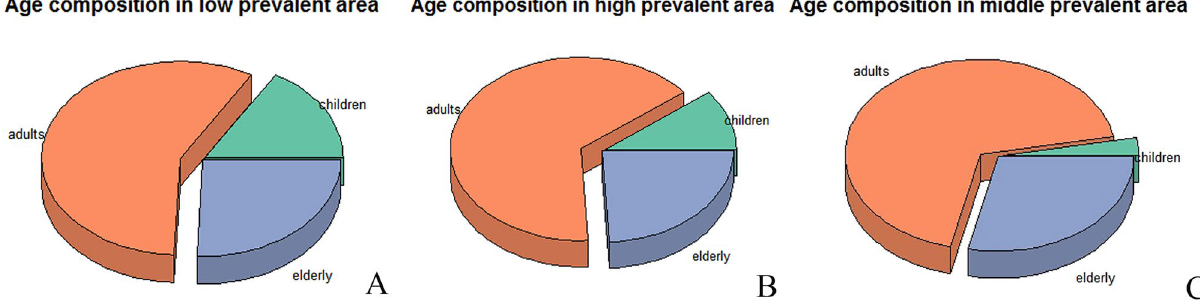
Figure 4. Age composition of individuals with traumatic fracture in regions of China classified according to COVID-19 prevalence.